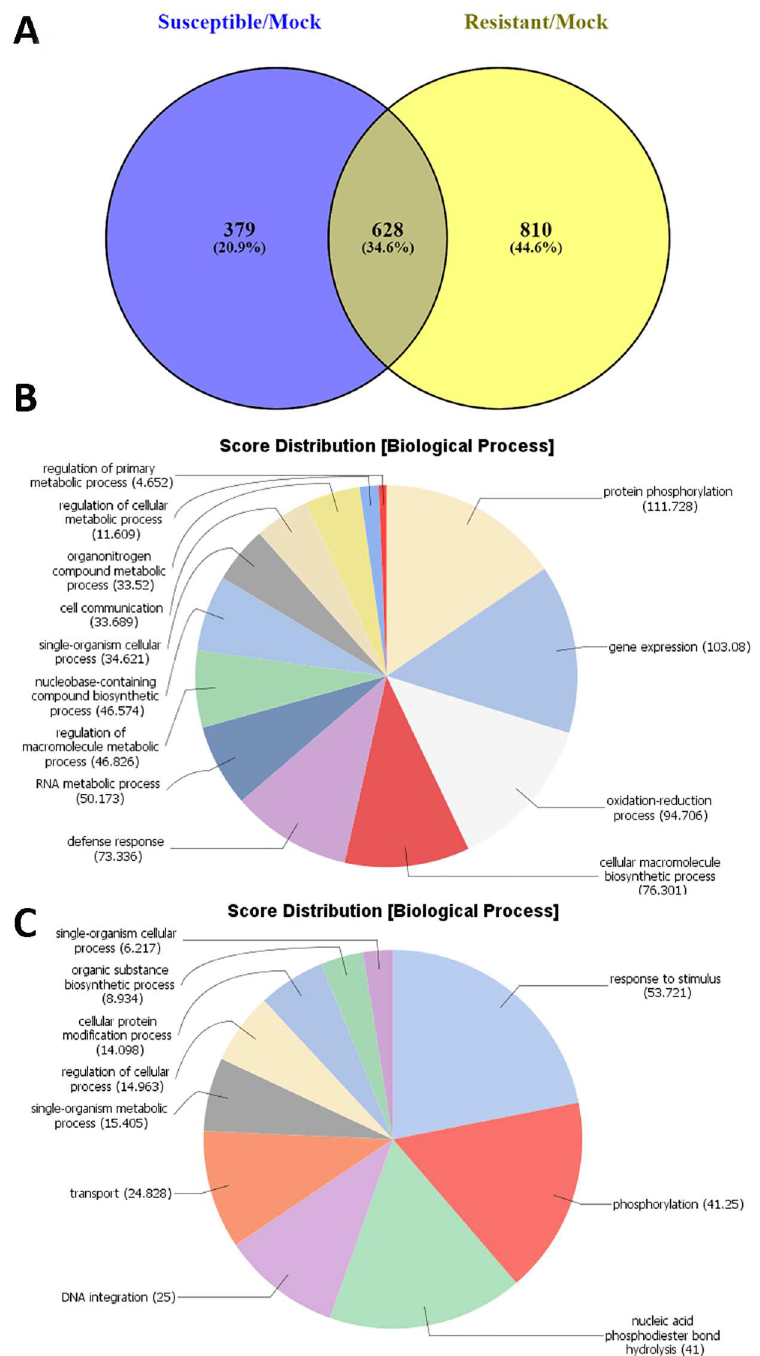
Fig 2. Differentially expressedgenes (DEGs) in alfalfa plants from cultivar Maverickin response to inoculation with P . syringae pv. syringae ALF3. (A) Venn diagramdepictingthe uniqueand common up- regulatedDEGs betweensusceptibleand resistant plants at 72 hours after inoculation. (B) Functional profilingof the uniquegenes up-regulated genesin resistant plants (810 DEGs) using the Blast2Go tool. (C) Functional profilingof the uniquegenesup-regulated genes in susceptible plants (379 DEGs).